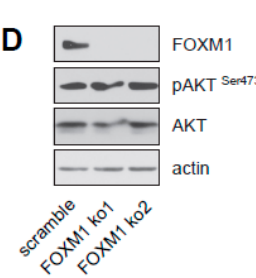
Figure 8. RASSF1A inhibits YAP1, and knockdown of YAP1 suppresses AKT1 activity, inhibits expression of ER α and FOXM1, and increases levels of FOXO3A. ( A ) Induction of RASSF1A expression in conditional RASSF1A MCF7 cells was achieved by culturing cells in the presence of 1 µ g / mL doxycycline. Cell extracts from induced and non-induced conditional RASSF1A cells were prepared 48 h after doxycycline administration and were analyzed by immunoblotting using the indicated antibodies. Actin served as a loading control (left panel). ( B ) Stable knockdown of YAP1 was performed in parental MCF7 cells using shRNAs (YAP1k.o.1 and YAP1k.o.2). Cell extracts were prepared 48 h after lentiviral transduction. Western blots of lysates from the two independent YAP1 shRNAs (YAP1k.o.1 and YAP1k.o.2) in MCF7 cells were probed with the indicated antibodies. Actin served as a loading control (upper left panel). Densitometric quantification of the western blot bands scramble: 100; YAP1ko1: 134; YAP1ko2: 177; detailed information about western blots are given at Figure S7. ( C ) Knockdown of FOXM1 in MCF7 cells using the shRNAs FOXM1k.o.1 and FOXM1k.o.2 was performed and mRNA was prepared 48 h after lentiviral transduction. Transcript levels of the indicated genes were analyzed by quantitative PCR. Mean values ± s.d. of three independent experiments are presented. P -value < 0.05 are indicated by asterisks. ( D ) Stable knockdown of FOXM1 was performed in parental MCF7 cells using shRNAs (FOXM1k.o.1 and FOXM1k.o.2). Cell extracts were prepared 48 h after lentiviral transduction. Western blots of lysates from the two independent FOXM1 shRNAs (FOXM1k.o.1 and FOXM1k.o.2) in MCF7 cells were probed with the indicated antibodies. Actin served as a loading